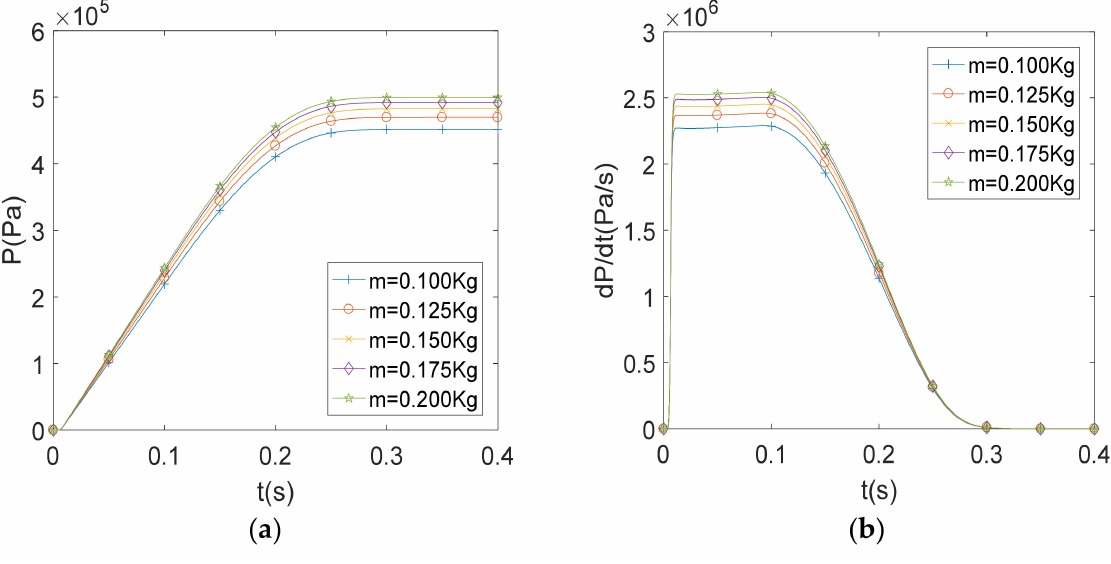
Figure 15. Influence of the mass of the valve core on pressure change rate: ( a ) pressure response; ( b ) pressure change rate